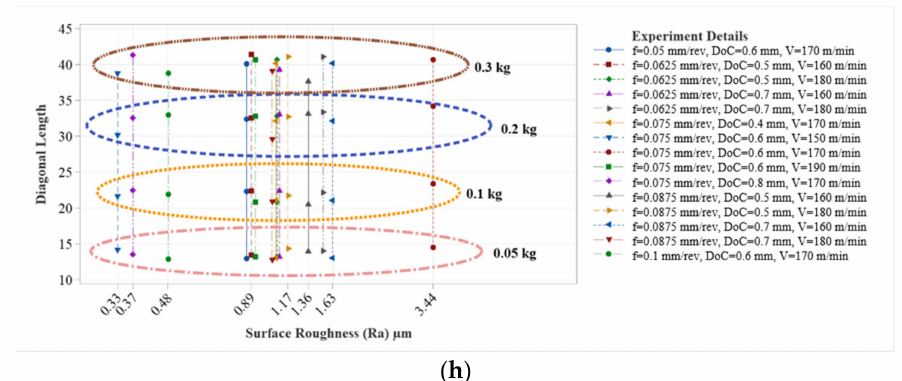
Figure 3. ( a – d ) Indentation photographs and ( e – g ) microhardness profiles of the machined specimens. ( h ) Diagonal length of indents at a 20 µ m depth versus the surface roughness for different indentation